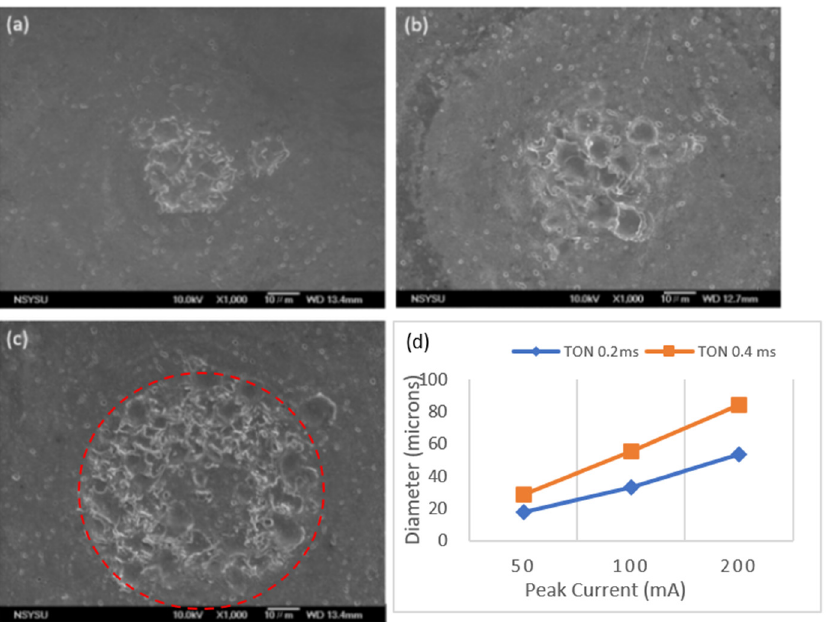
Figure 7. Effect of peak current on craters of the bottom surface with ( a ) 50 mA, ( b ) 100 mA, ( c ) 200 mA, and its effective circle (SEM 1000×). ( d ) The effective diameter of damaged crater circle vs. current.